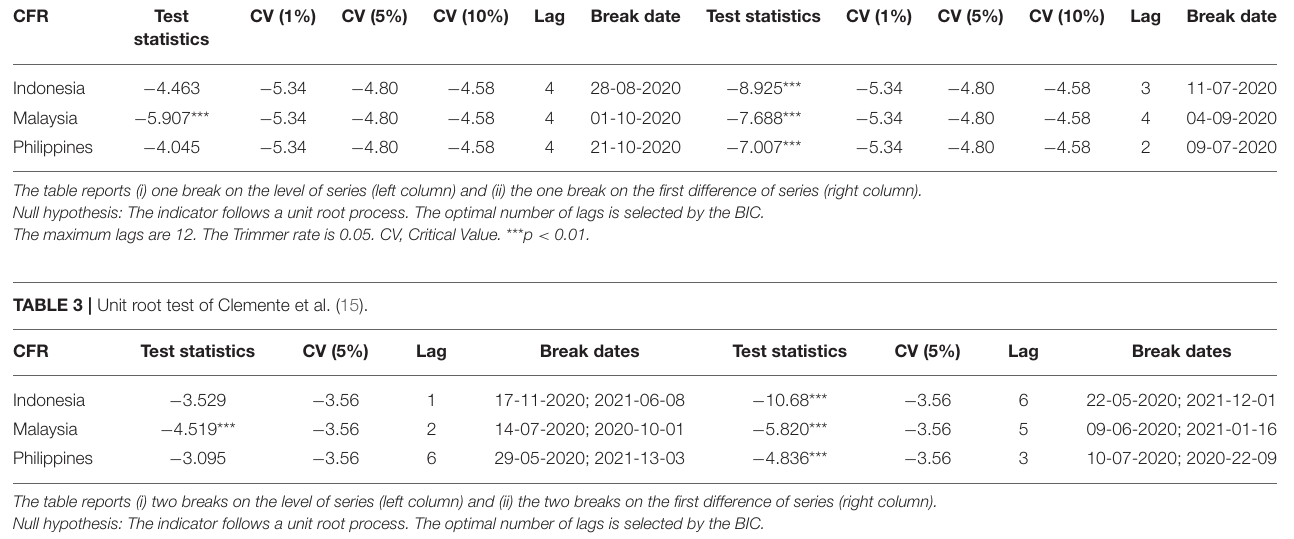
TABLE 2 | Unit root test of Zivot and Andrews (14).